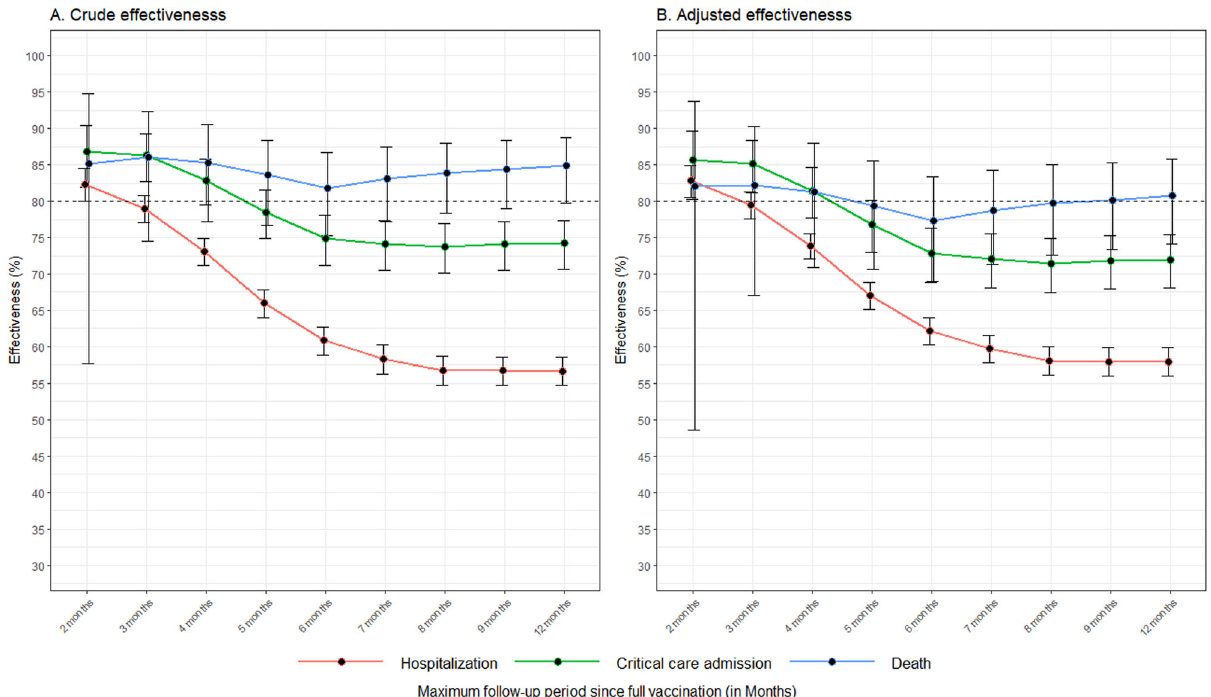
Fig. 3 Decline in vaccine effectiveness over 12 months of follow up. Vaccine effectiveness estimated at increasing follow-up periods using the Cox proportional hazard regression model. The red, green and blue curves indicate hospitalization, critical care admission and death respectively. Error bars represent the 95% con fi dence intervals of the true effectiveness, n = 2,199,772 individuals (1,099,886 vaccinated and 1,099,866 unvaccinated matched controls). A Effectiveness estimated without adjustment. B Effectiveness estimated adjusting for age, sex, presence of comorbidity, ethnicity, and the calendar month of entry into the